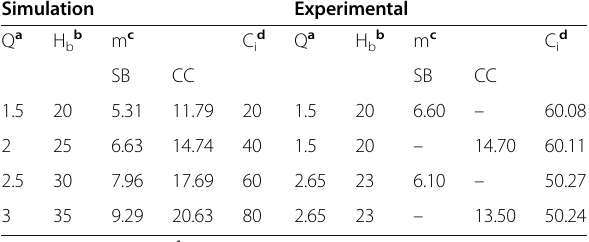
Table 2 Column operation parameters in ACT removal using SB and CC Simulation